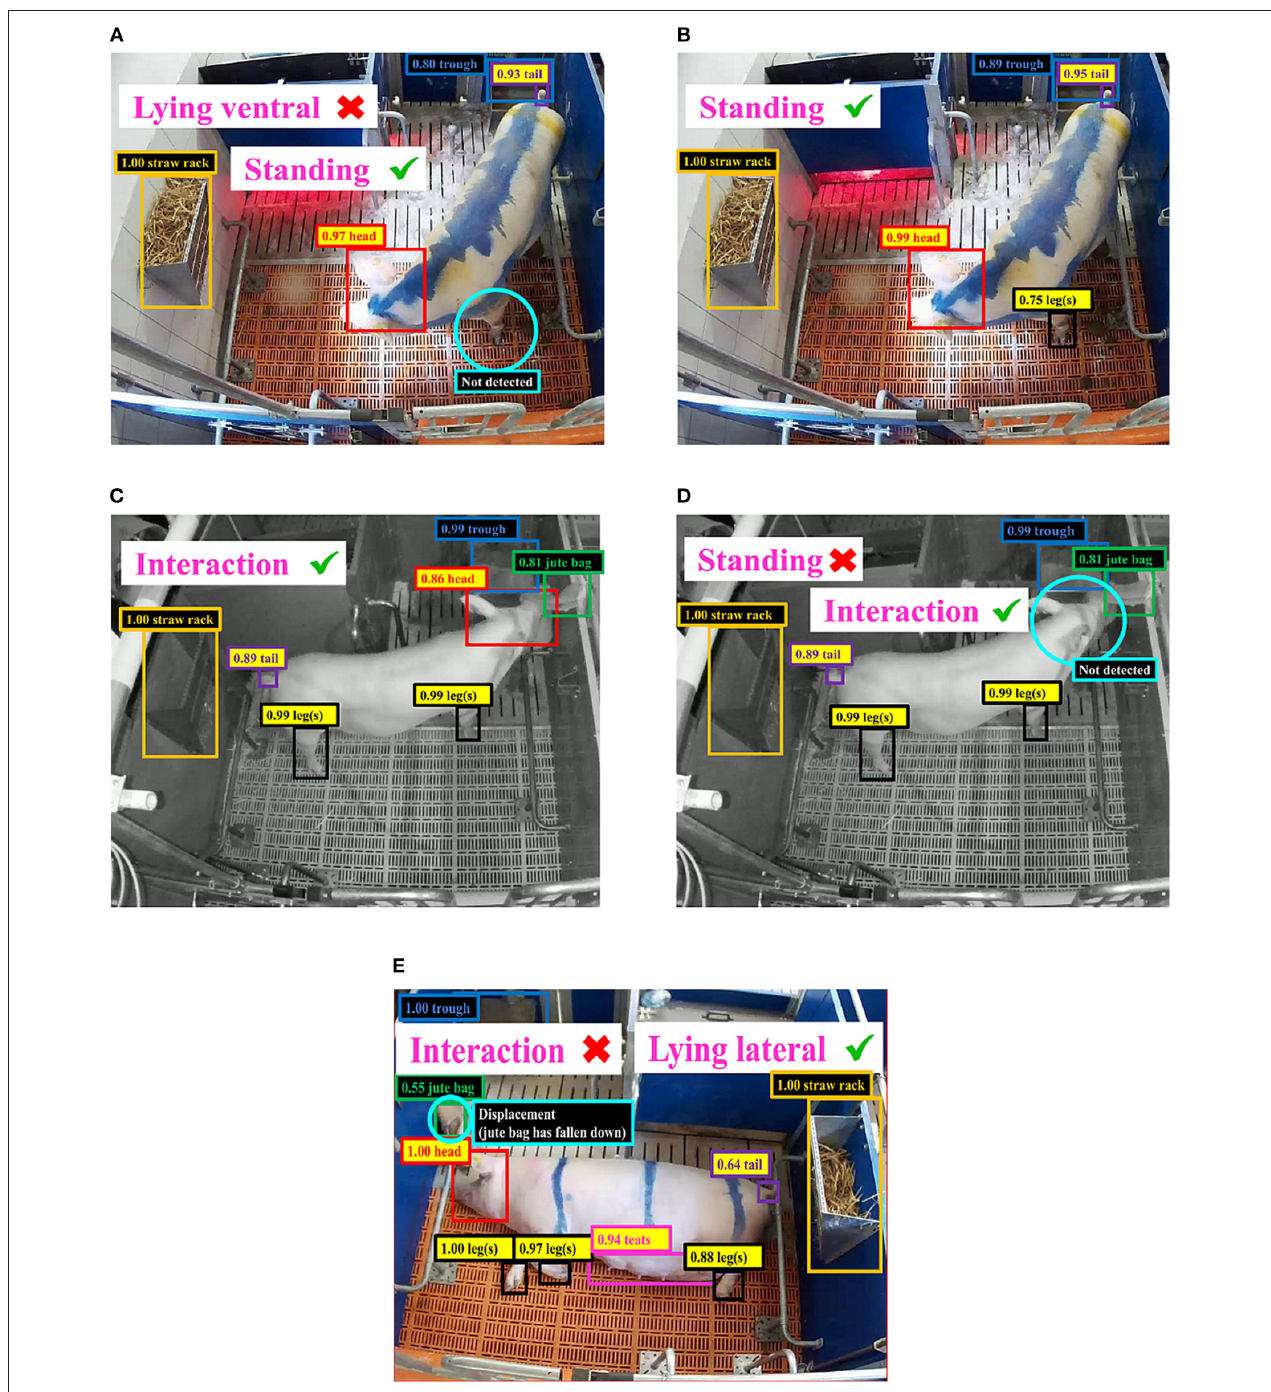
FIGURE 8 | (A–E) Examples of struggling situations resulting in fail classification (The BB’s were edited to highlight the features and the cyan circles highlight the fail detections/problems).